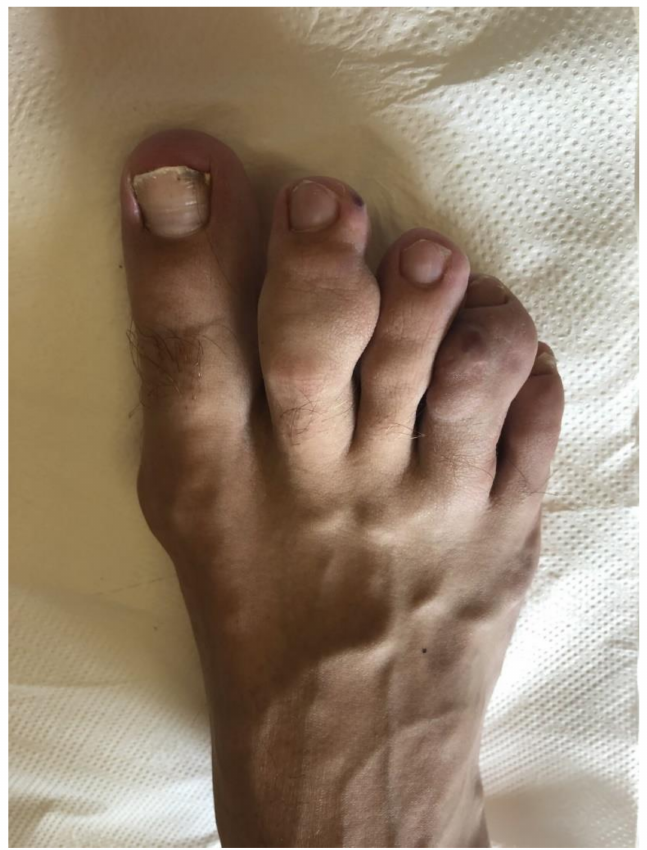
Figure 1. Masses of the spindle cell hemangioma on the toes of the right